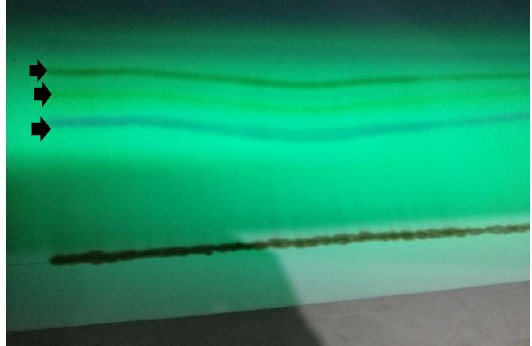
Figure 3. Preparative TLC chromatogram for